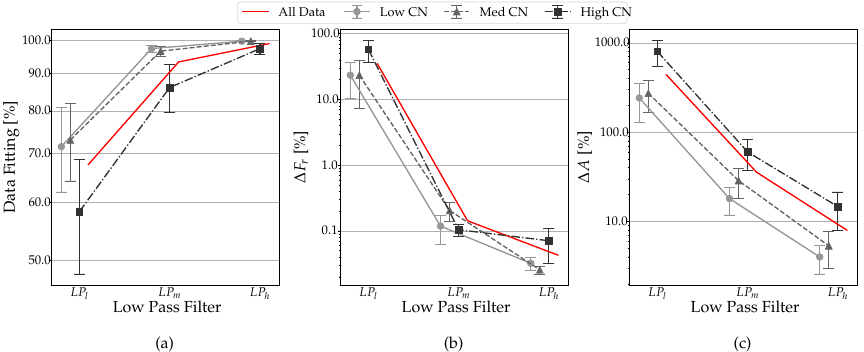
Figure 12. Low-pass trends in the function of the LP filter and CN values: ( a ) data fitting, ( b ) ∆ F, ( c ) ∆